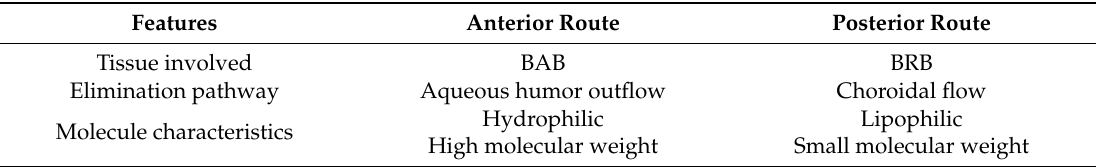
Table 2. Comparison of the anterior and posterior route of drug elimination from the vitreous humor